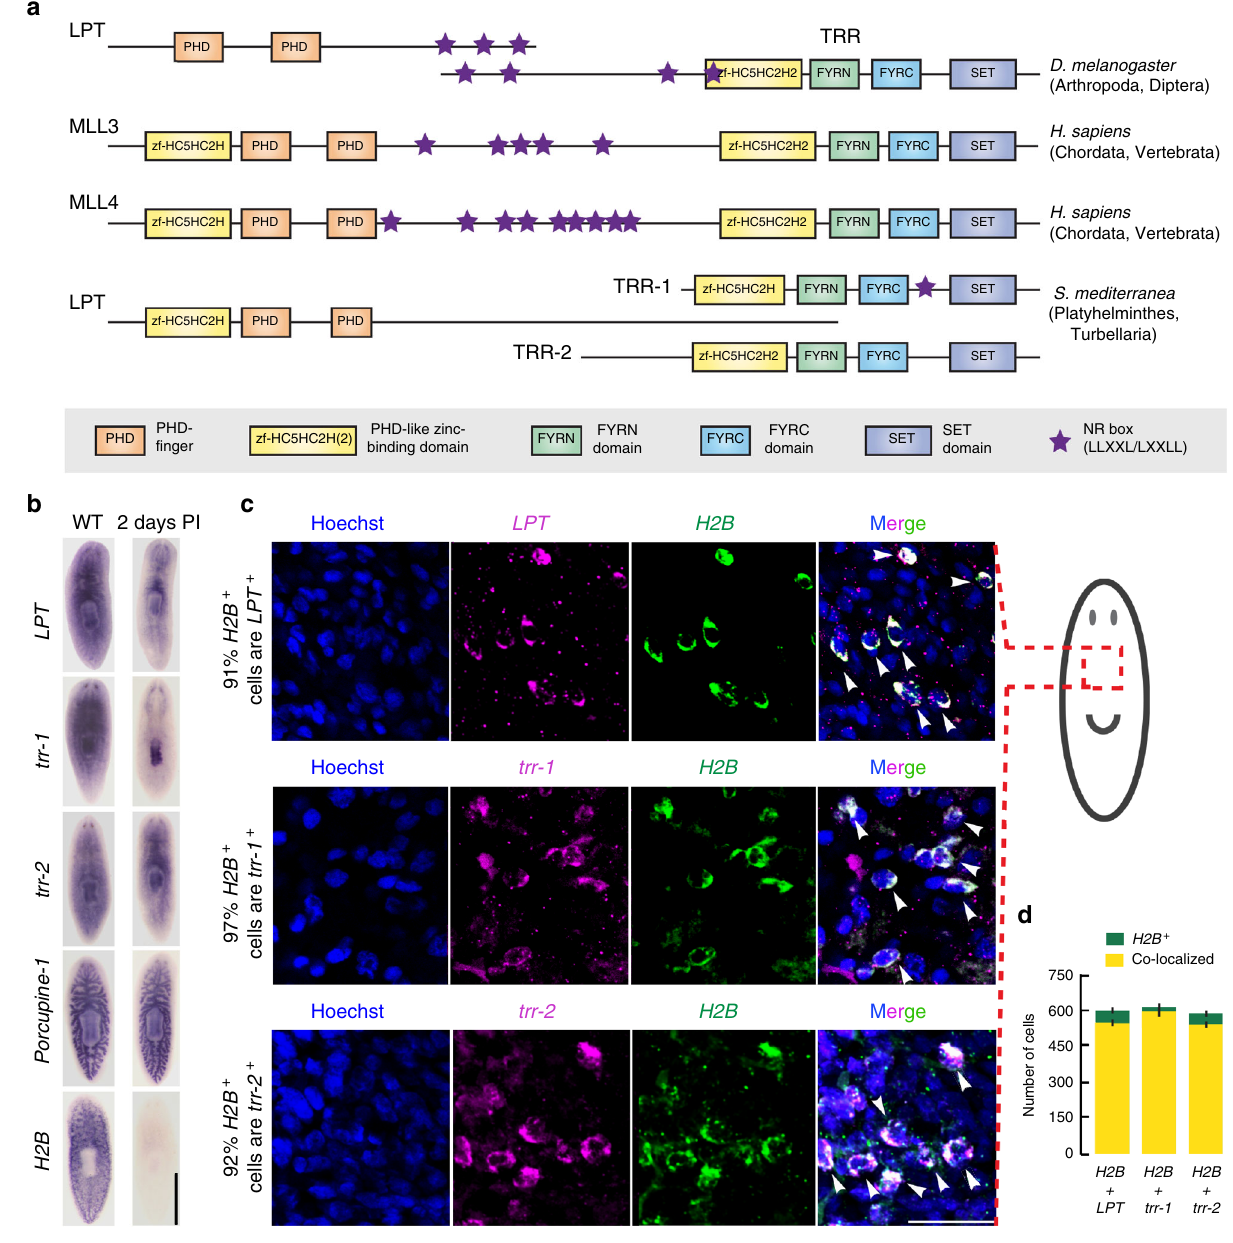
Fig. 1 S. mediterranea has three partial Mll3/4 orthologs expressed in stem cells. a A schematic depicting the structure and domain composition of MLL3/ MLL4 proteins in D. melanogaster , H. sapiens and S. mediterranea . b genes ’ expression pattern in wildtype (WT) and two days following a lethal dose (60 Gy) of gamma irradiation (PI = post-irradiation). Porcupine-1 (expressed in the irradiation-insensitive cells of the differentiated gut) and H2B (expressed in the irradiation-sensitive neoblasts) are used as a negative and positive control respectively. Ten worms per condition were used. Scale bar: 500 μ m. c White arrows point to examples of cells double-positive for Mll3/4 transcripts and H2B transcripts. The schematic shows the body area imaged. Scale bar: 50 μ m. d Graph showing the raw cell counts used for percentage estimates in ( c ). Green color represents all counted H2B -positive cells, yellow represents H2B - positive cells also expressing an Mll3/4 ortholog. Error bars represent Standard Error of the Mean (SEM). Ten animals per condition were